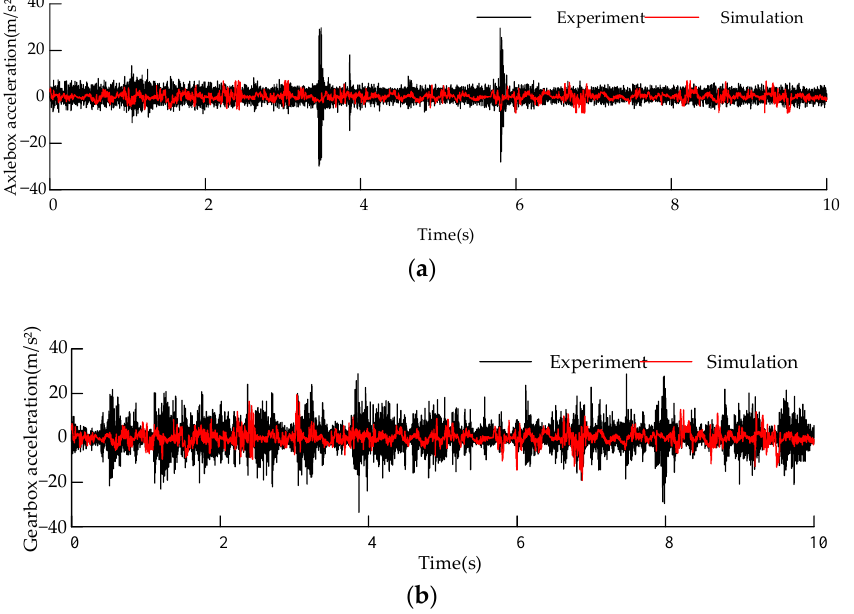
Figure 3. Comparison of the experimental data and simulation data in the vertical direction: the time series ( a ) on the axle box and ( b ) gearbox.